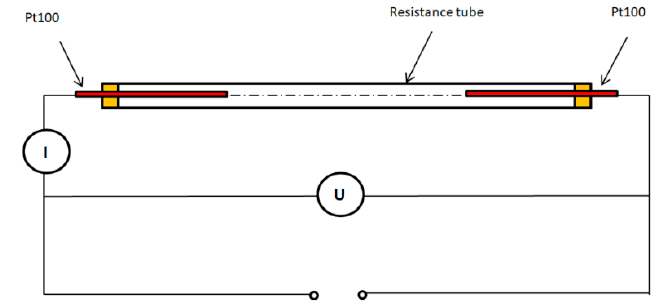
Figure 3. Scheme of the heated cylinder.